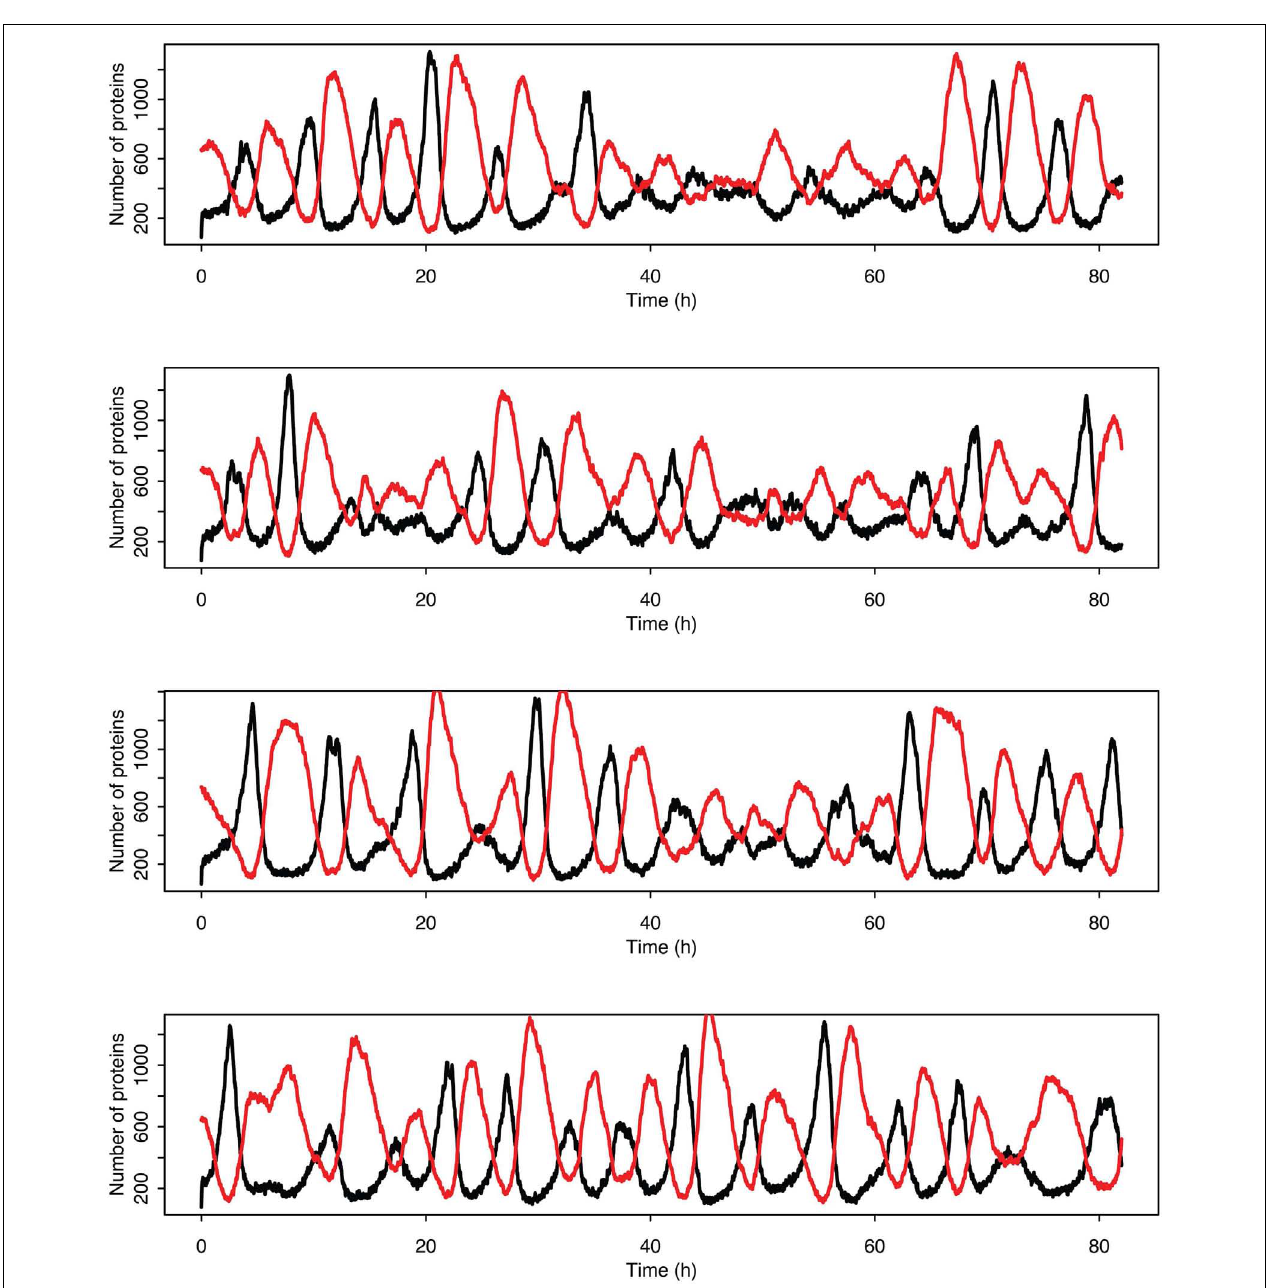
FIGURE 14 | Examples of individual stochastic realizations when p53 production is past the upper bifurcation point. p53 is in black MDM2 is in red.